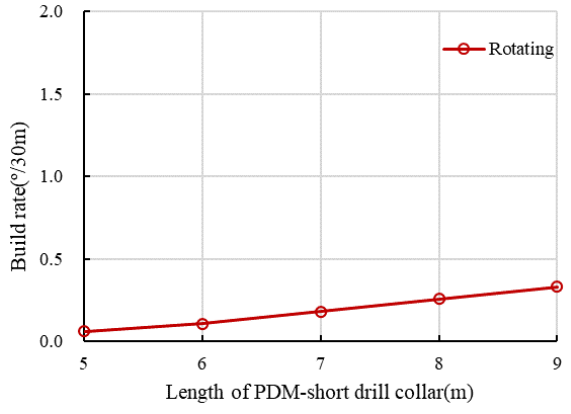
Fig. 21. Rotating build rate VS length of PDM-short collar